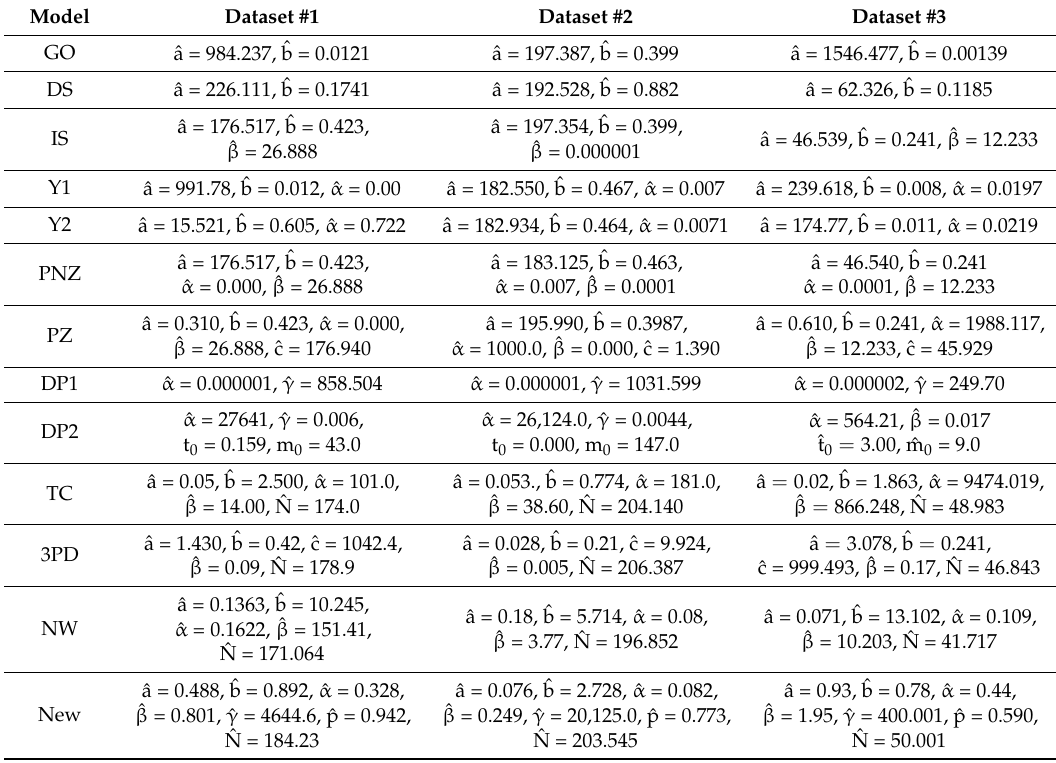
Table 5. Model parameter estimation from